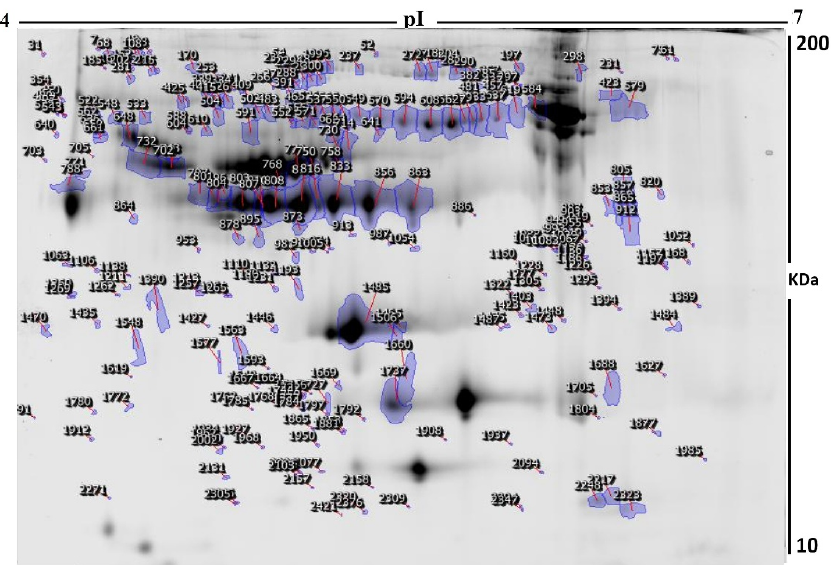
Figure 2 . Fluorescence labeled (CyDyes)-2D-DIGE numbered spots indicate those proteins that were identified to be differentially abundant (defined as fold-change >1.5, p < 0.05) between the two groups (controls and CUD). These were successfully identified with matrix-assisted laser desorp- tion/ionization time of flight (MALDI-TOF) mass spectrometry (MS). MW, protein molecular weight; pI, isoelectric point.